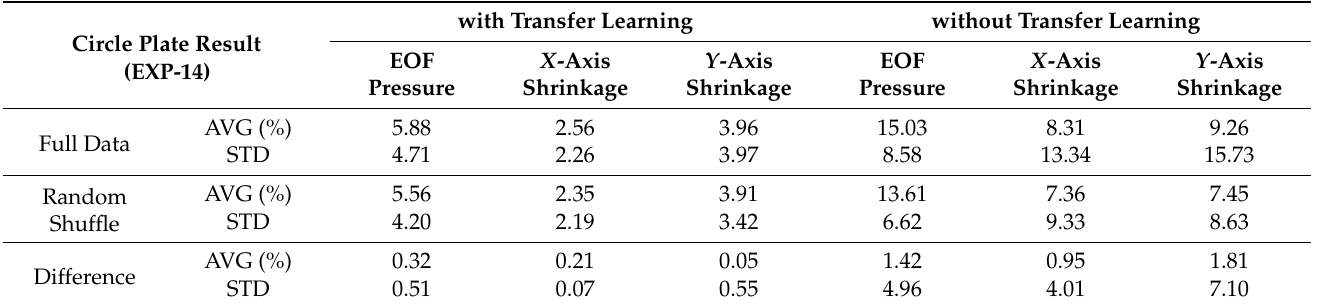
Table 23. Results of transfer learning for the round plate model